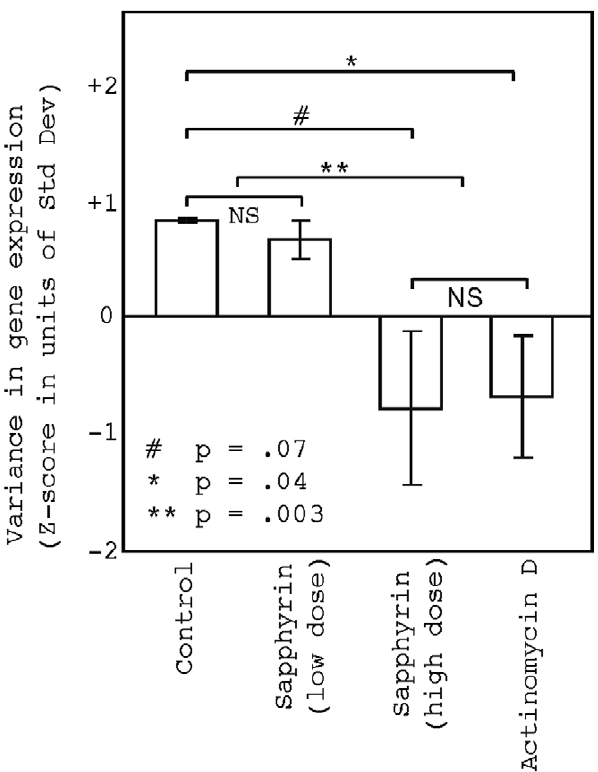
Figure 5. Transcription inhibitors lead to decreased variance in gene expression. Gene expression data from a publically available dataset show that treatment of a lung cancer cell line with actinomycin D and a high dose of sapphyrin results in decreased variance in gene expression compared to treatment with mannitol or a low dose of sapphyrin. Error bars represent standard error.